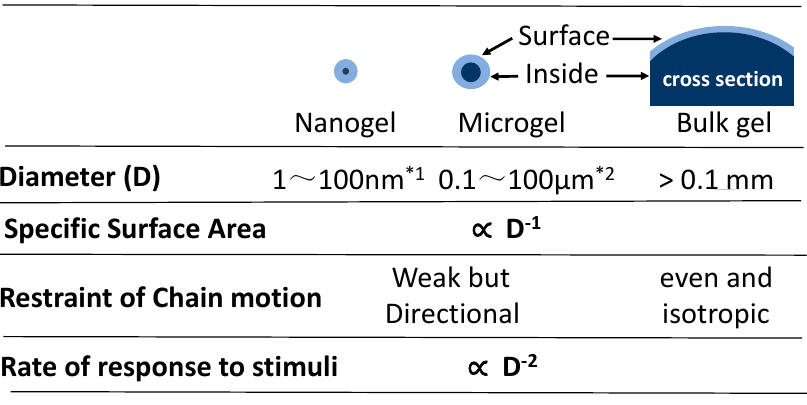
Figure 1. Microgels (MG) and their alternatives. Gels 2020 , 6 , x FOR PEER REVIEW